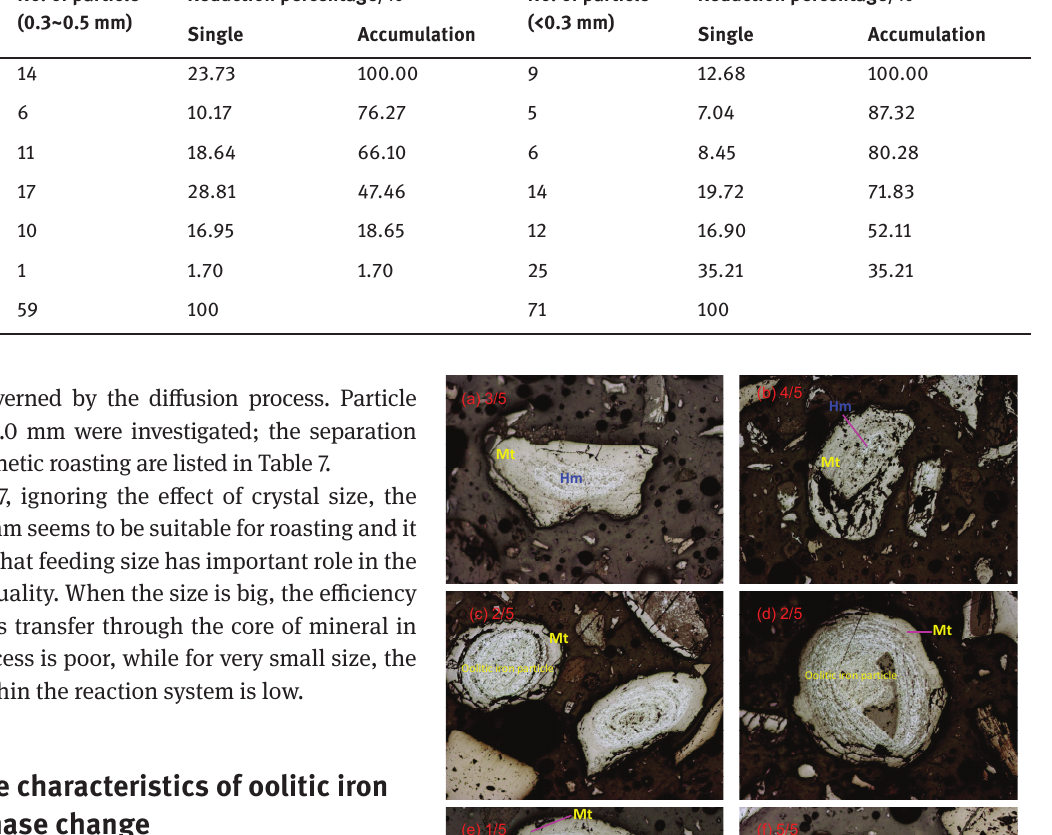
Table 8: Quantitative results of reduction area (with ratio) and its distribution after magnetic roasting. Reduction